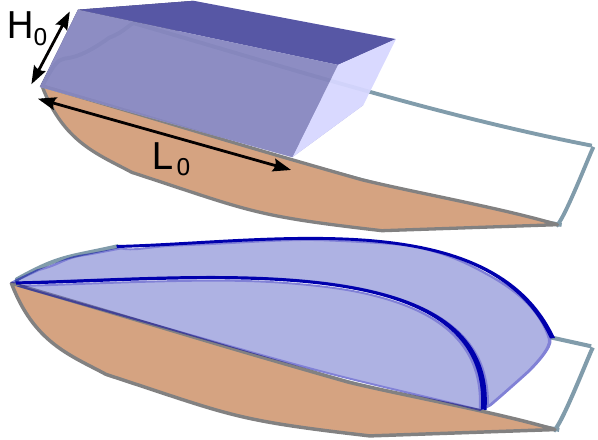
Fig. 4. Schematic view of the movement of a block of ice on an incline, with no snowfall or melting. Top panel: initial configuration with length L 0 and thickness H 0 . Bottom panel: the block at a later time t . The block continues to flow, becoming longer and